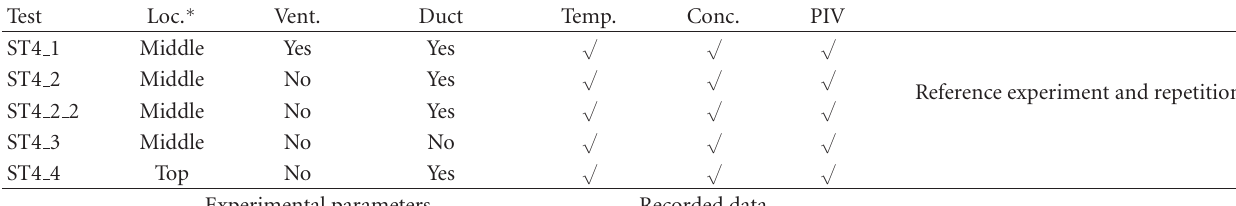
Table 1: Main parameters for the di ff erent